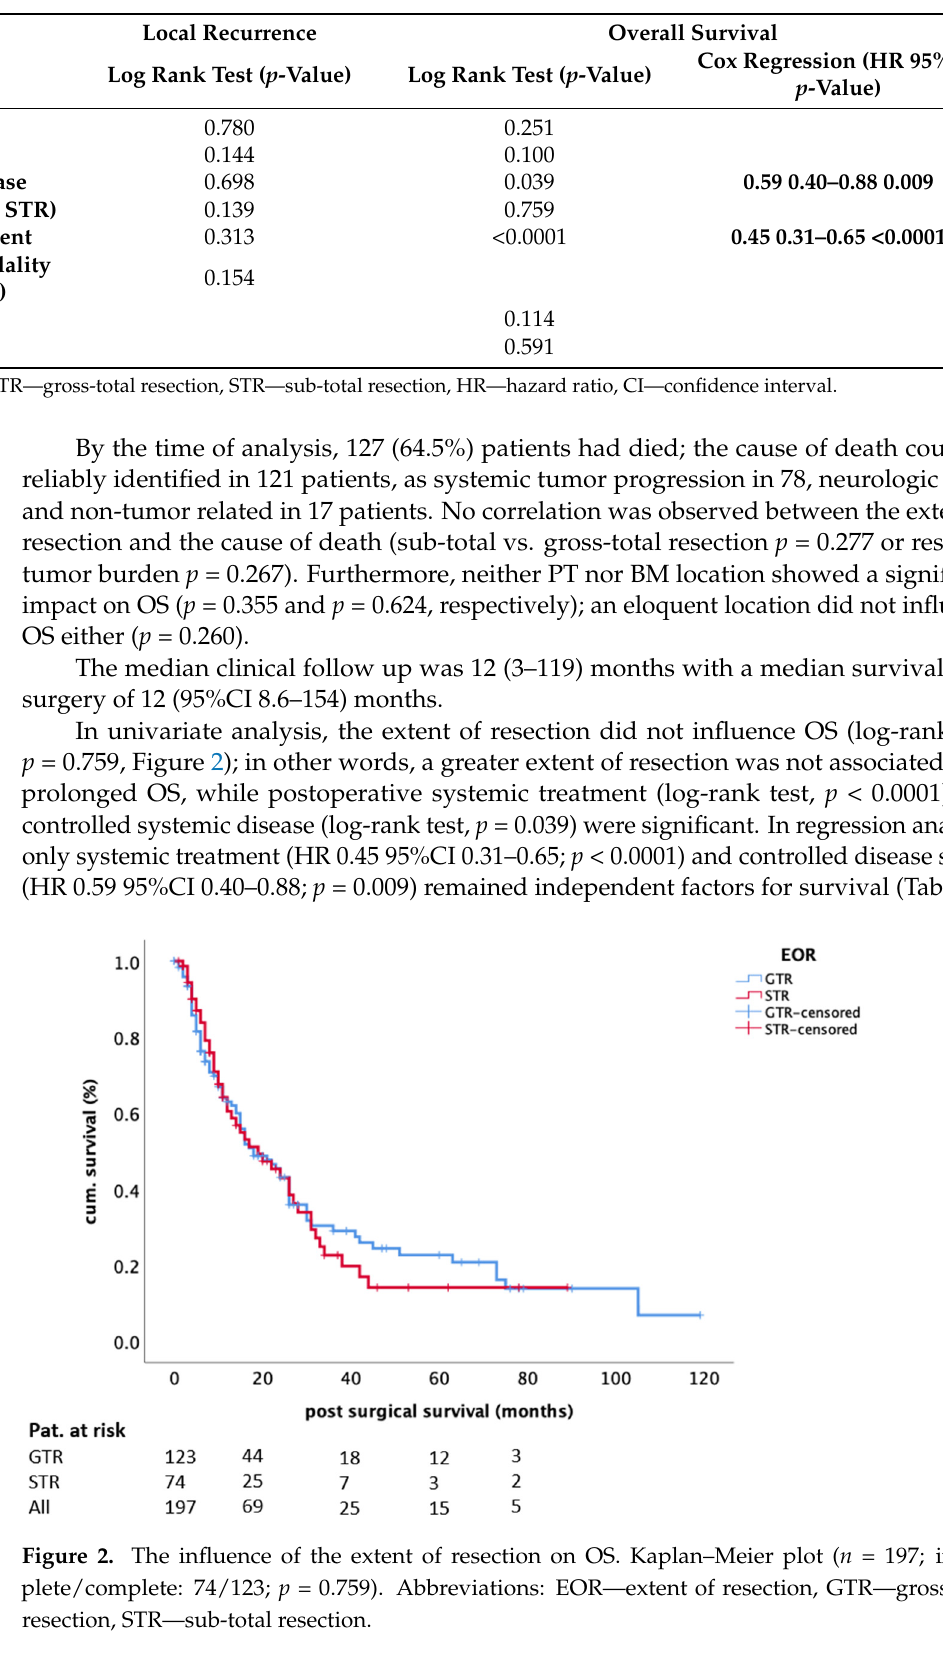
Table 3. Parameters predicting local recurrence and overall survival. Bold indicates statistical significance, calculated by log-rank test and cox regression.